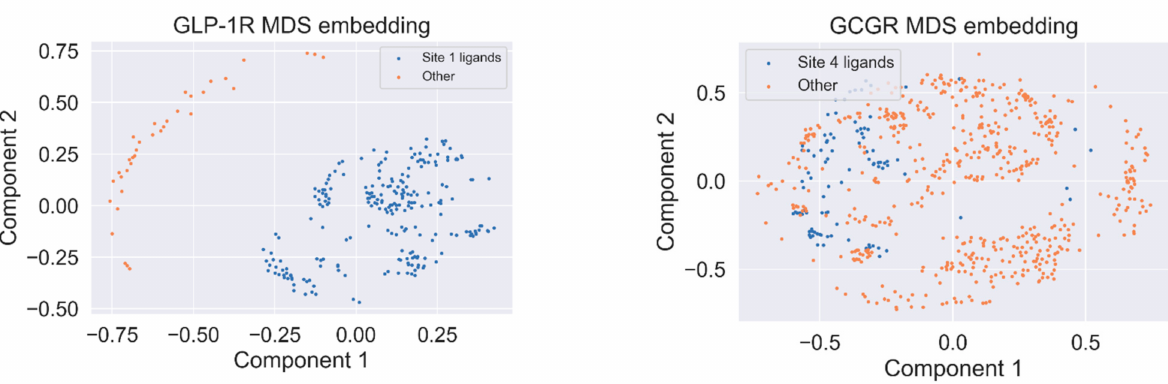
Figure 6. Multidimensional scaling embedding (MDS) for the relative similarity of ligand structures in the GLP-1R dataset ( left ) and the GCGR dataset ( right